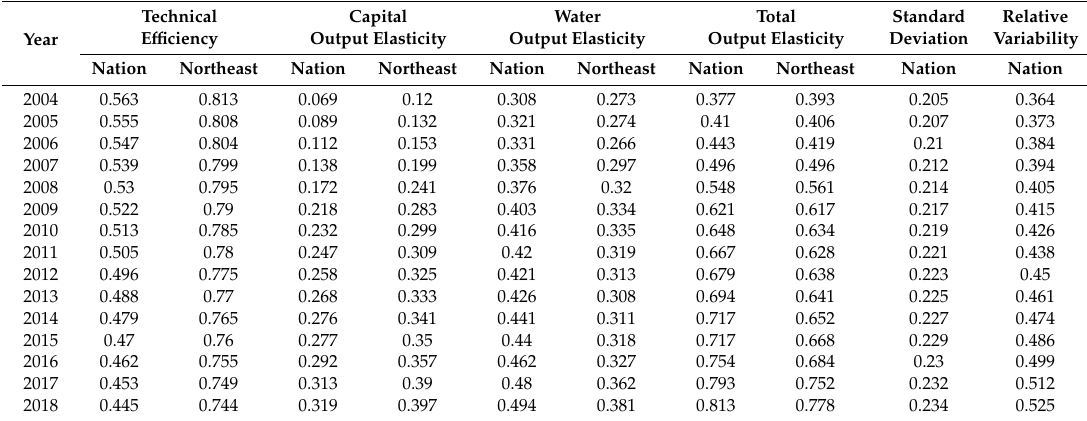
Table 7. Comparison between national and northeast levels (2004–2018).